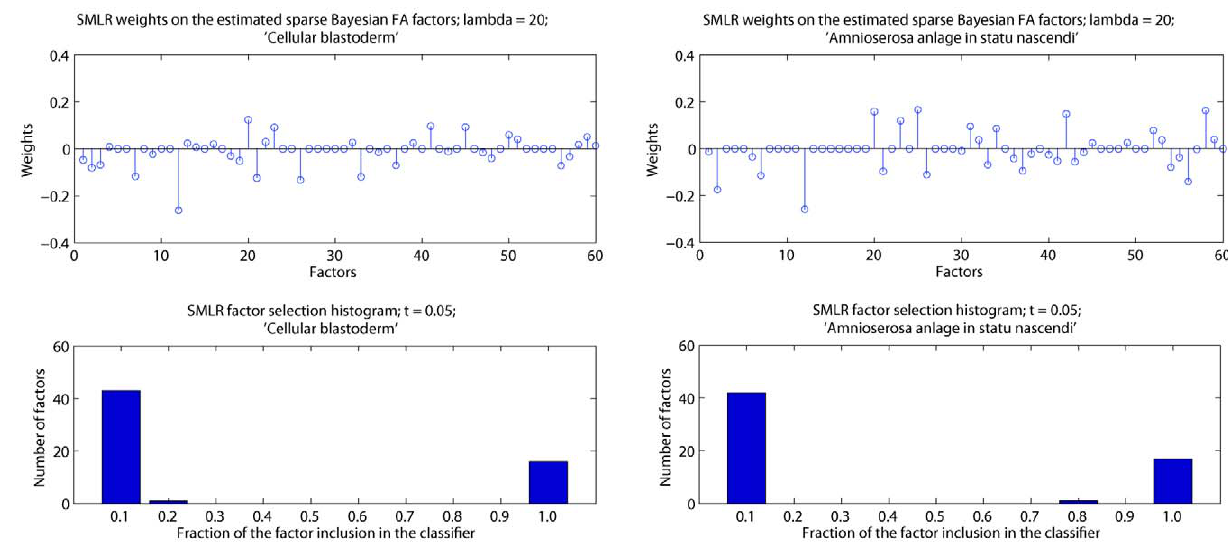
Figure 7. SMLR analysis on the estimated sBFA factors on data set S l , for two randomly selected annotation terms. The top row 4 { 6 shows the SMLR mixing weights on the factors, for a regularization parameter l ~ 20 ; the x-axis represents the FA factors: the first 10 factors for a grid size of 48 6 24 , the next 20 factors for a grid size of 60 6 30 and the last 30 factors for a grid size of 80 6 40 . The bottom row contains histograms with the number of factors selected as relevant over 1,231 LOO-CV trials, with a cut-off value at t ~ 0 : 05 . Each feature appears once in the graph. The more mass concentrated at the two ends, the more consistent the classifier is in identifying relevant factors.